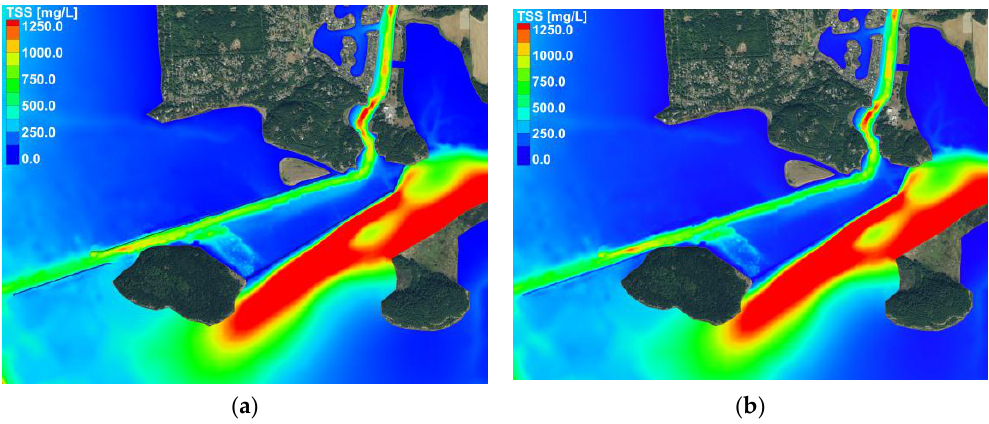
Figure 12. Time averaged total suspended sediment (TSS) distribution (20 days) for ( a ) baseline conditions and ( b ) Jetty Repair Scenario, SCN-1. The difference plot at the end of this section shows the difference between baseline conditions and SCN-1 for shear stress and TSS.